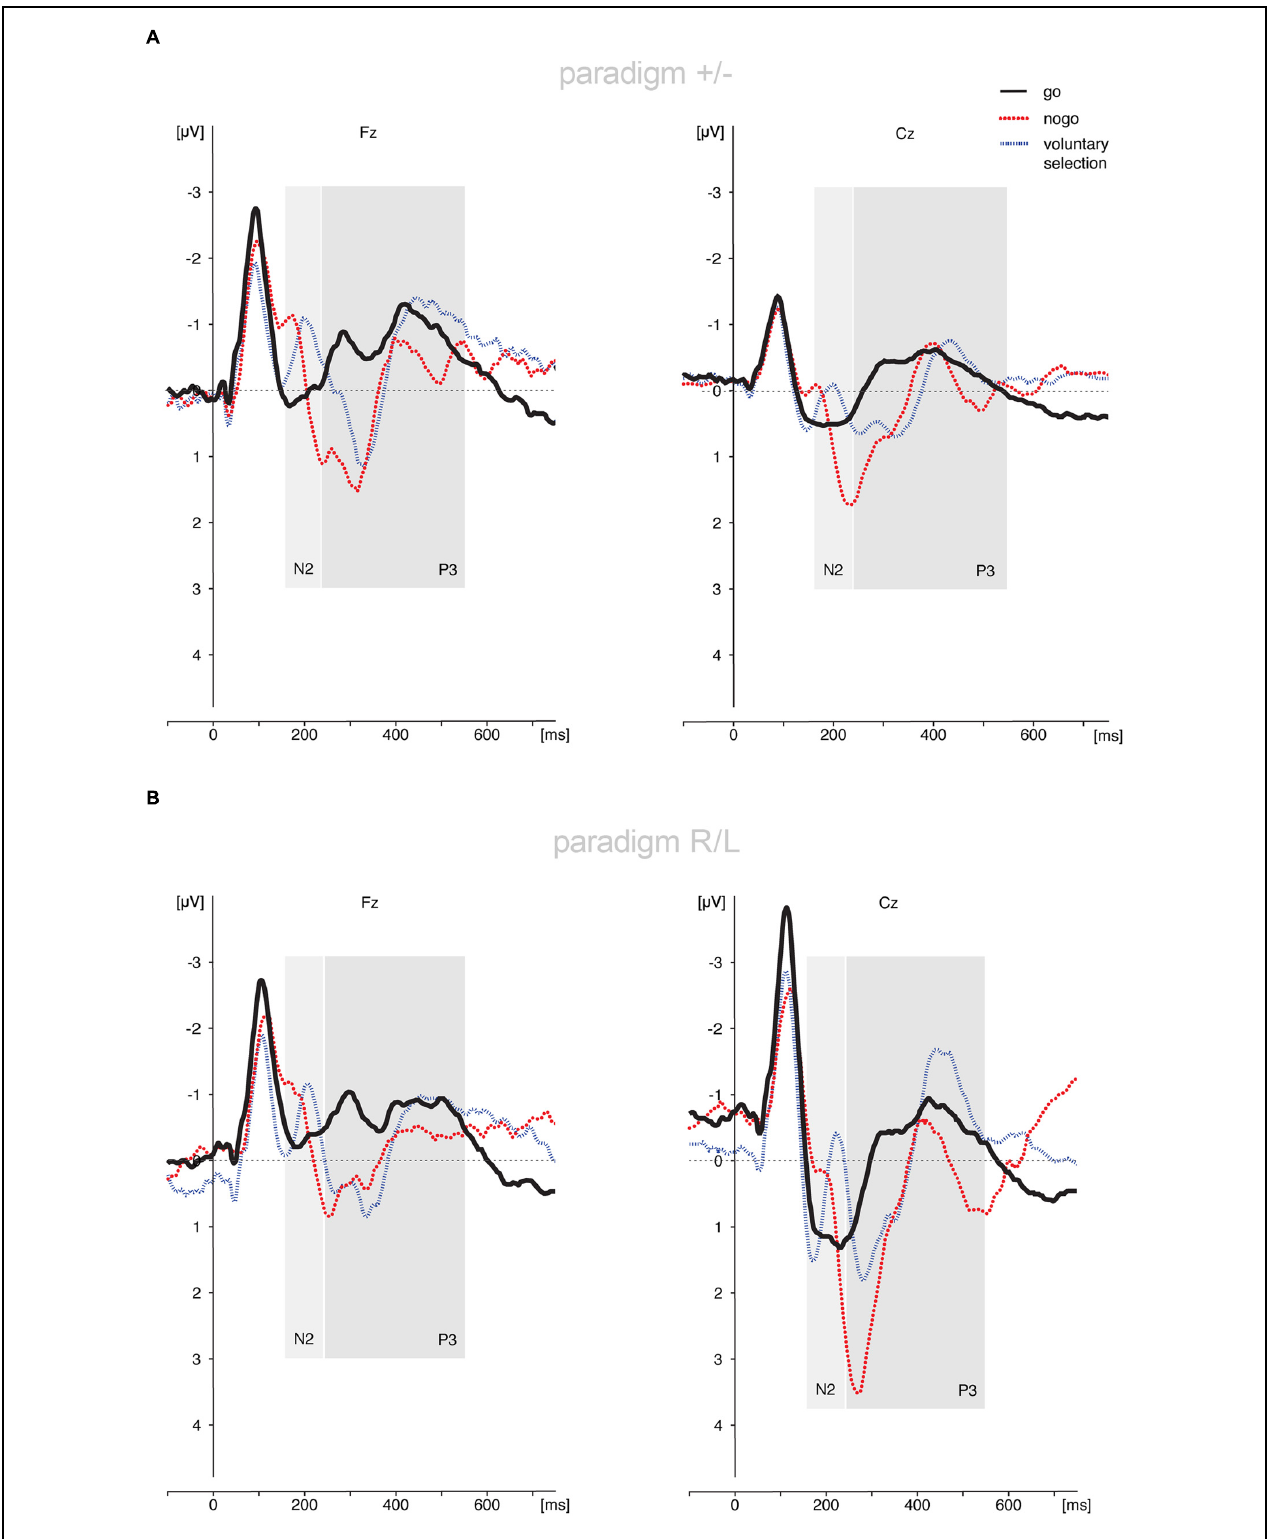
FIGURE 2 | Auditory evoked potentials of healthy controls. (A) ERPs concerning the paradigm + / − ; (B) ERP results regarding the paradigm R/L. Subjects showed increased fronto-centrally located N2 amplitudes during the voluntary selection task and nogo condition compared to go. The P3 amplitude was located in fronto-central brain areas during the nogo condition and the voluntary selection condition. Abbreviations µ V, microvolt; ms, milliseconds.